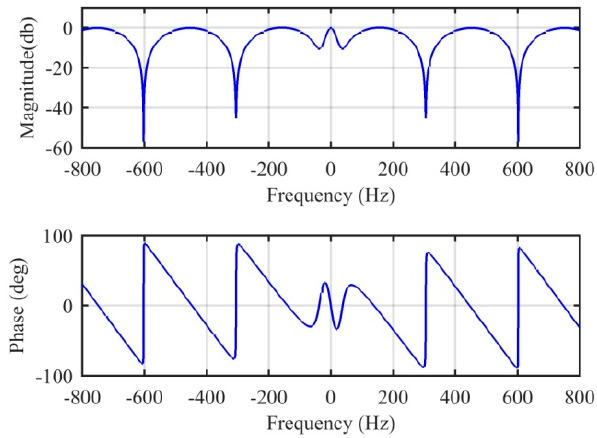
Figure 9. Bode diagram of EDSC.